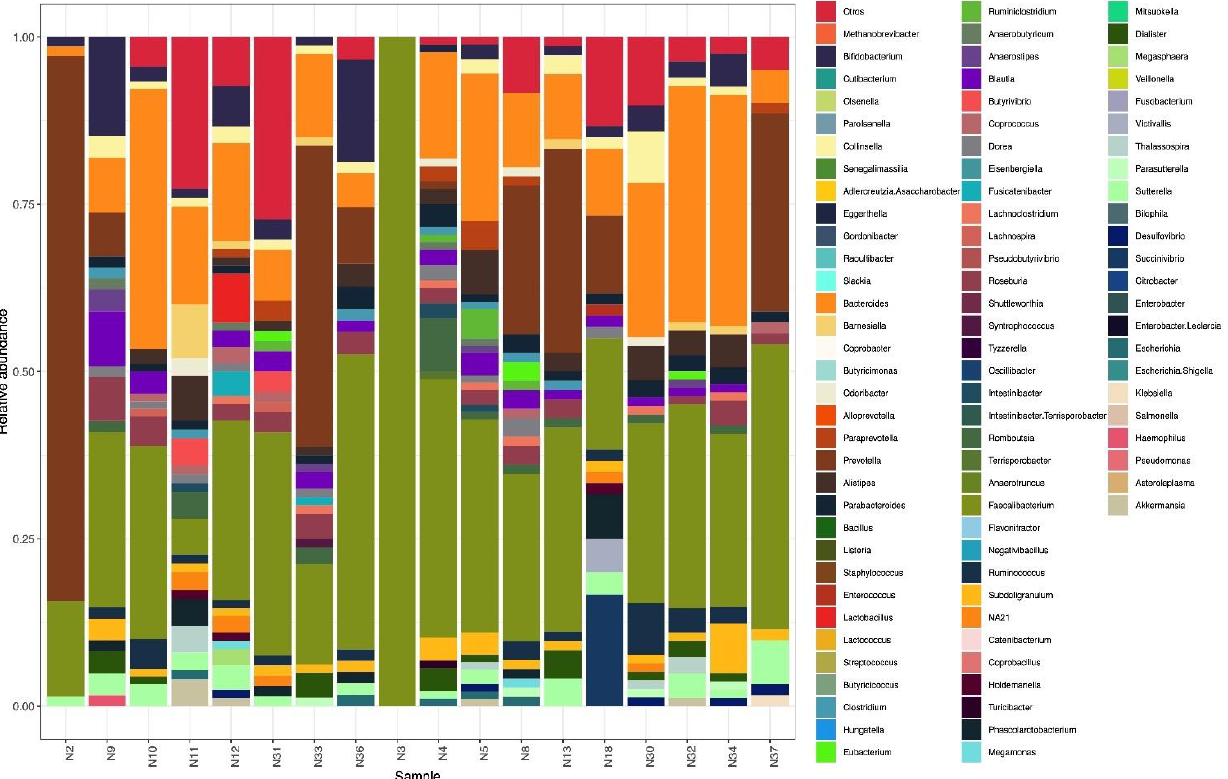
Figure 2. Genera diversity in DNA samples from adolescent fecal samples. The genus Faecalibacterium was found in all samples but was not detected as a predominant bacterial genus in any of the three groups of adolescents of the study.